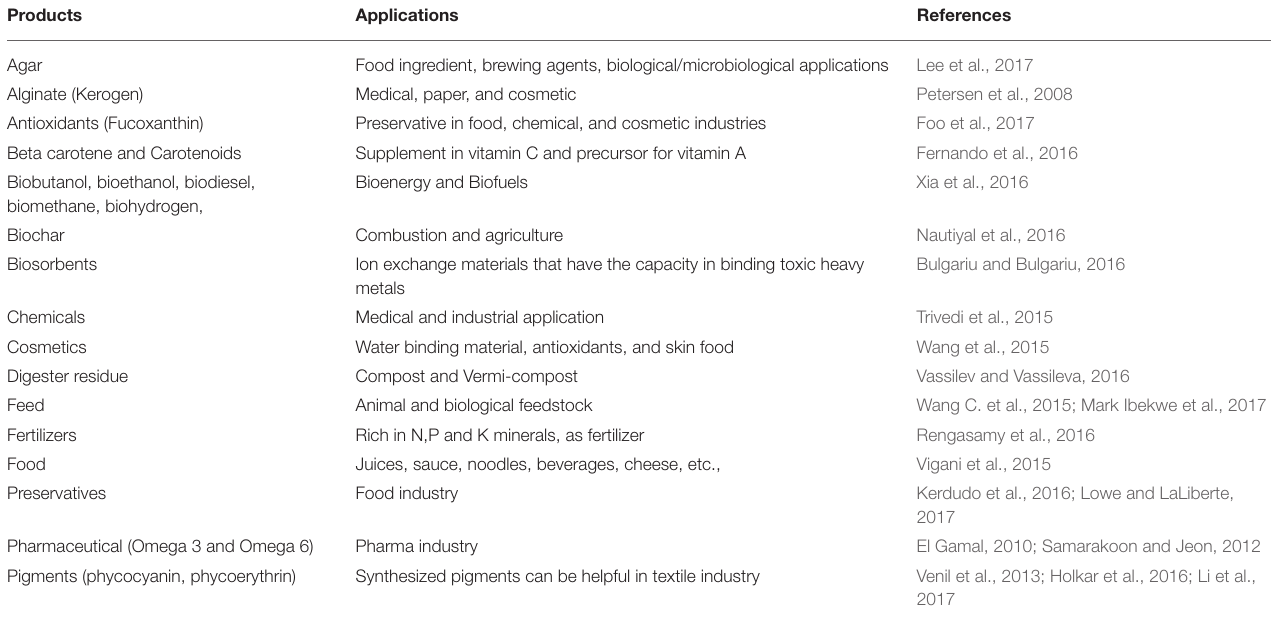
TABLE 2 | Products from algae using CO 2 as a substrate and their